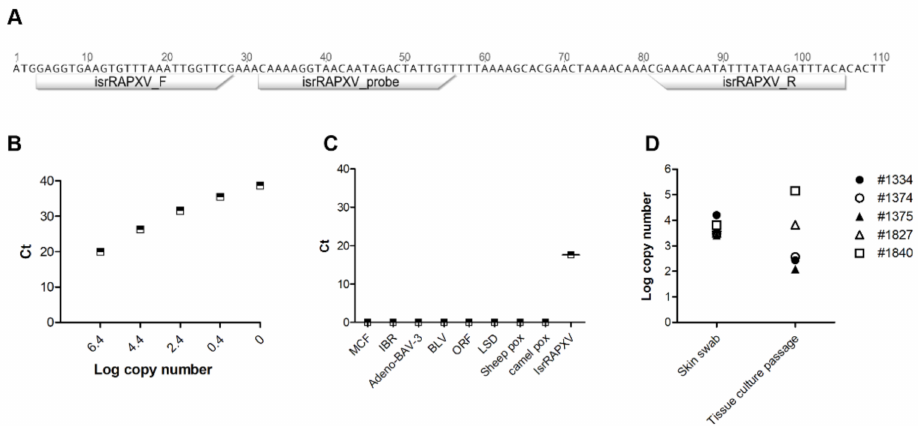
Figure 4. Development of RT-qPCR for detection of poxvirus in suckling bats. ( A ) Scheme showing partial sequence of E9L gene (Acc. No. MK542650) used to design isrRAPXV molecular detection assay. Annotations represent primers and probes location. ( B ) Standard curve with newly designed primer and probe for poxvirus molecular detection. ( C ) Specificity of the qPCR in detecting IsrRAPXV. ( D ) Detection of poxvirus in clinical samples and virus isolation on Vero cell line.